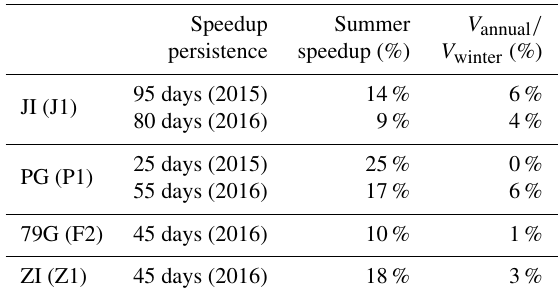
Table 1. Speedup persistence and seasonal percentage increase in speed relative to winter and annual background for each glacier for the Sentinel 1 dataset. Speedup persistence has an uncertainty of ± 12 days due to the image acquisition interval of Sentinel